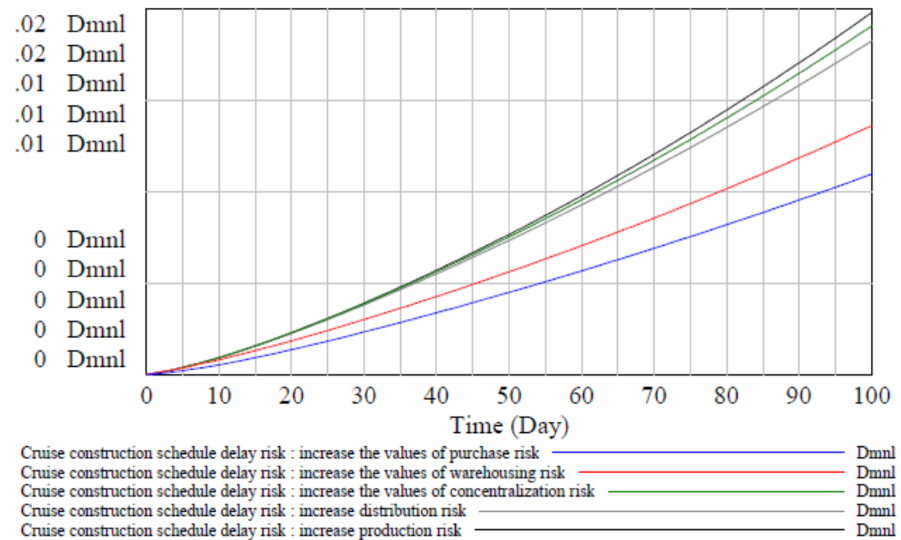
Figure 8. Comparison of cruise schedule delay risk when only one kind of risk